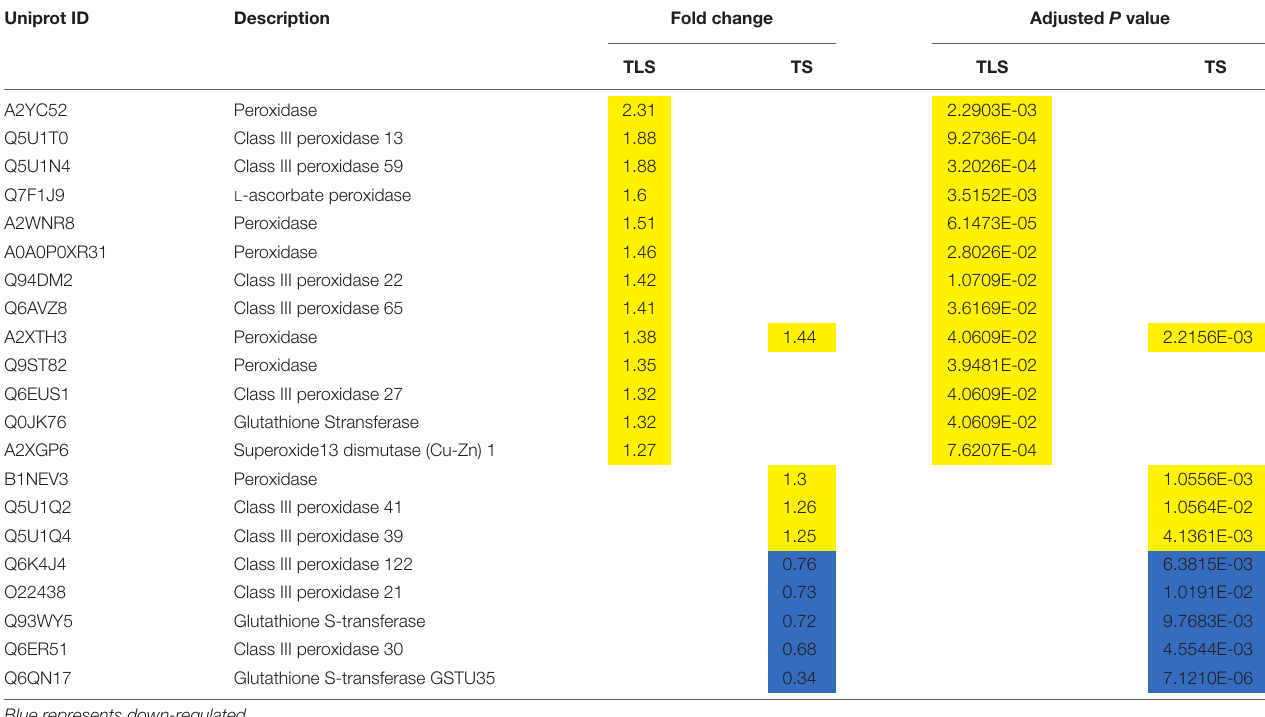
TABLE 3 | Changes in protein abundance associated with ROS scavenging in the three-leaf stage (TLS) and the tillering stage (TS) as identified by iTRAQ. Uniprot ID